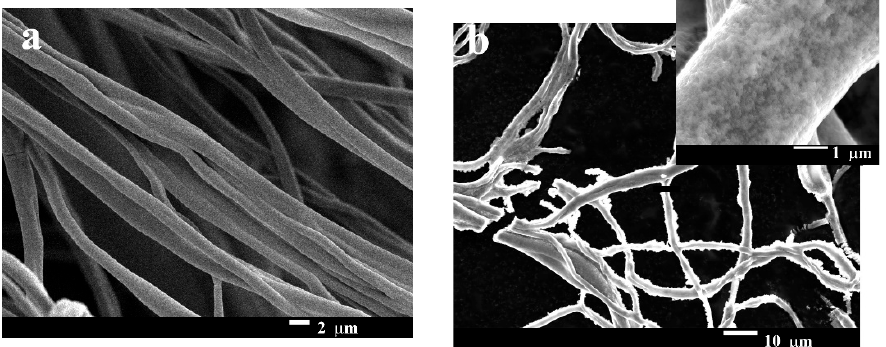
Figure 3. SEM images of pristine gelatin nanofibers ( a ) and gelatin nanofibers covered by ZnO NPs (GNF@ZnO) ( b